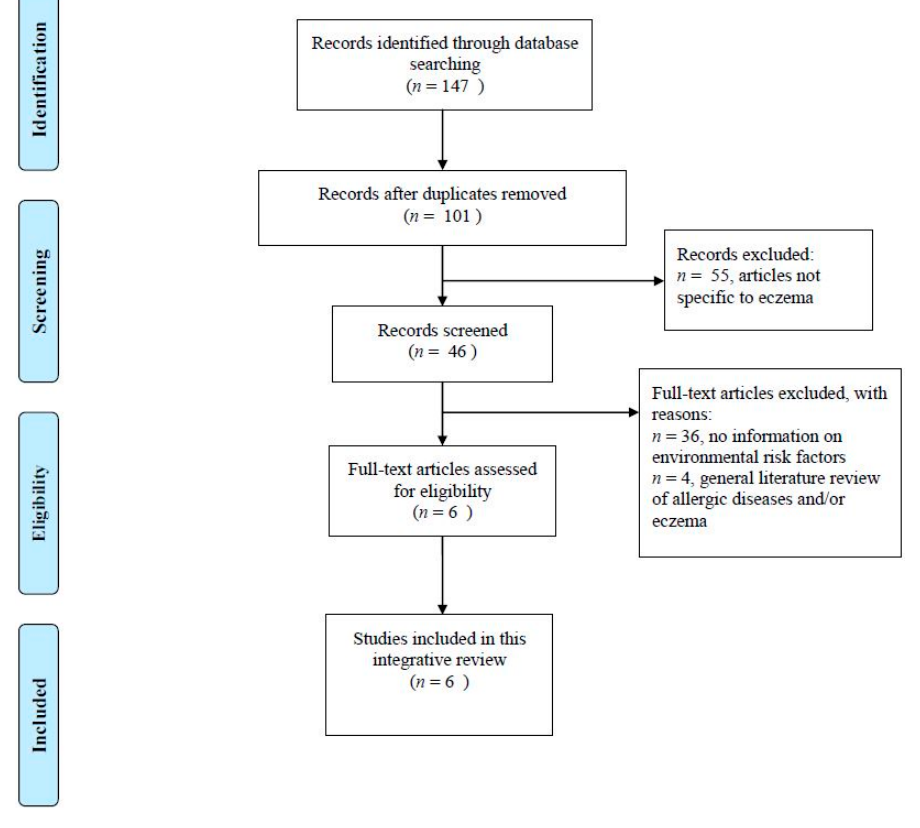
Figure 1. Flow diagram.